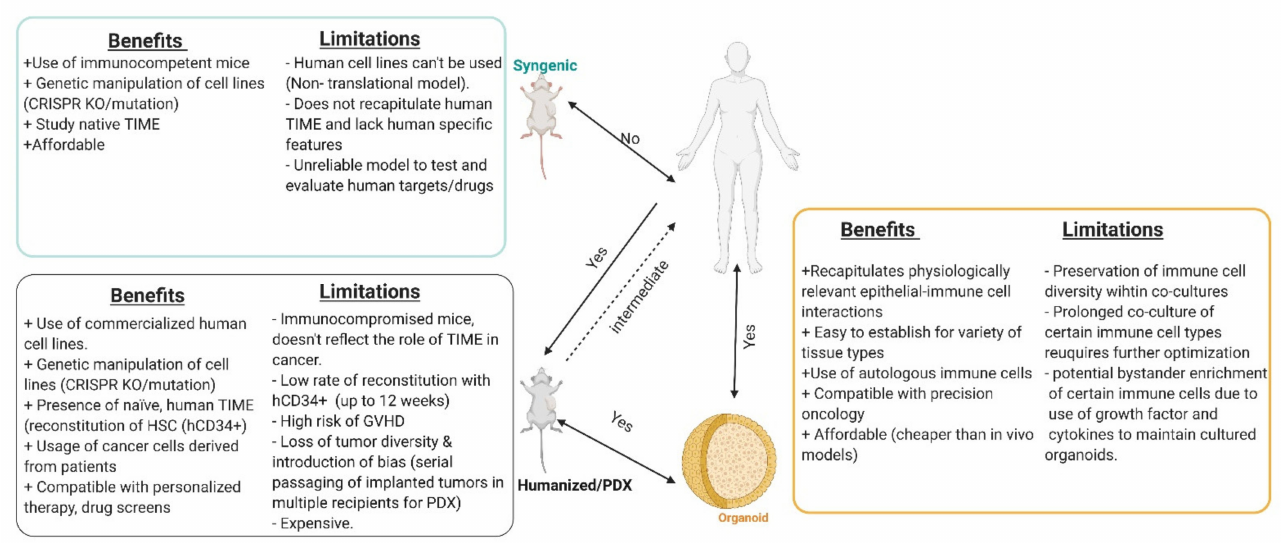
Figure 3. Comparison of the benefits and limitations of in vitro and in vivo experimental models. Created with BioRender. com (accessed on 6 April